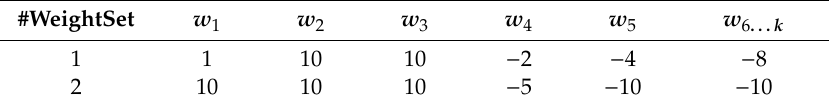
Table 1. OF2 weights tested in the